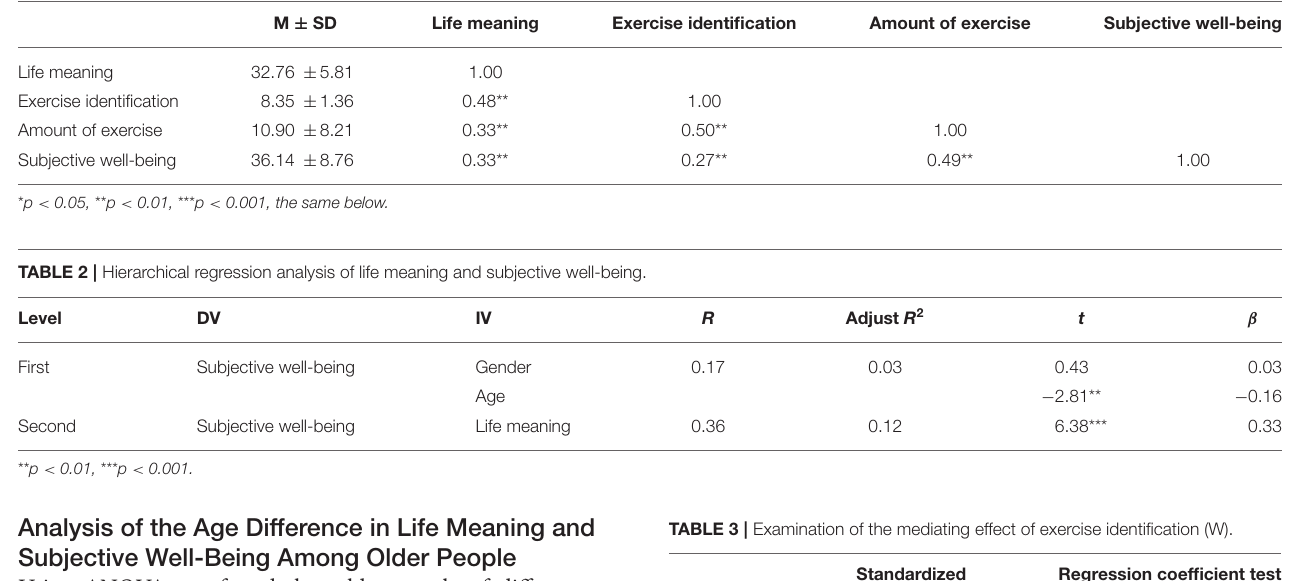
TABLE 1 | Correlation analysis of the variables.